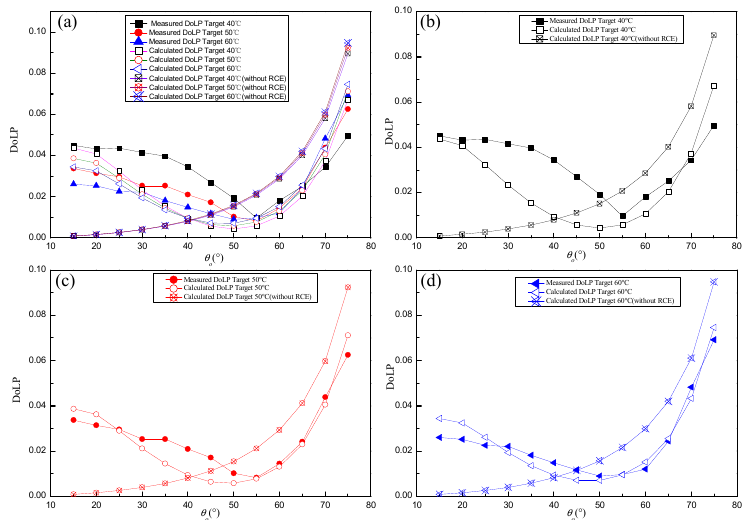
Figure 7. The DoLP of the object at different temperatures: ( a ) comparison between simulation re- sults and experimental results; ( b ) comparison results at 40 °C; ( c ) comparison results at 50 °C; and results and experimental results; ( b ) comparison results at 40 ◦ C; ( c ) comparison results at 50 ◦ C; and ( d ) comparison results at 60 °C. ( d ) comparison results at 60 ◦